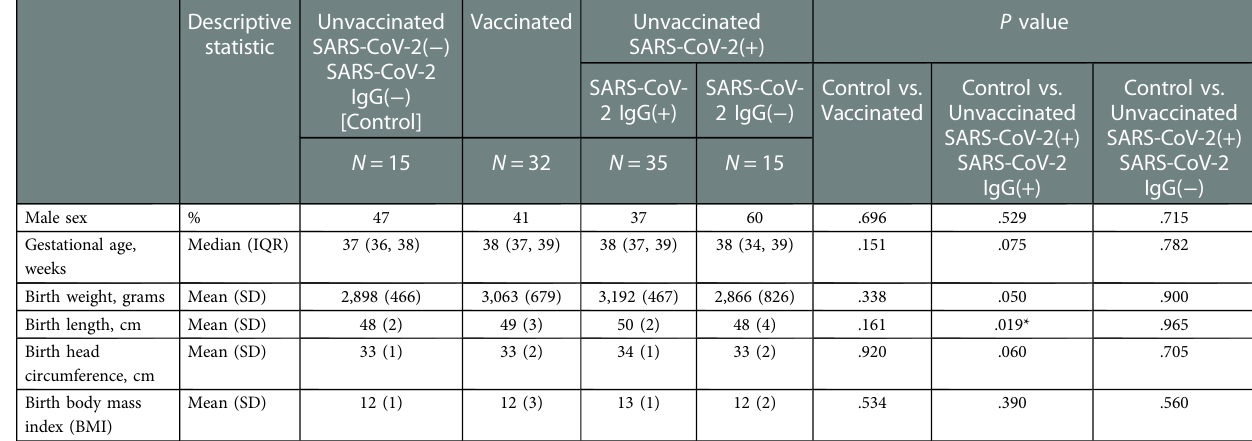
TABLE 3 Neonatal demographics strati fi ed by study groups based on SARS-CoV2 exposure/vaccination and presence of neonatal SARS-Cov2 speci fi c IgG, N =97.